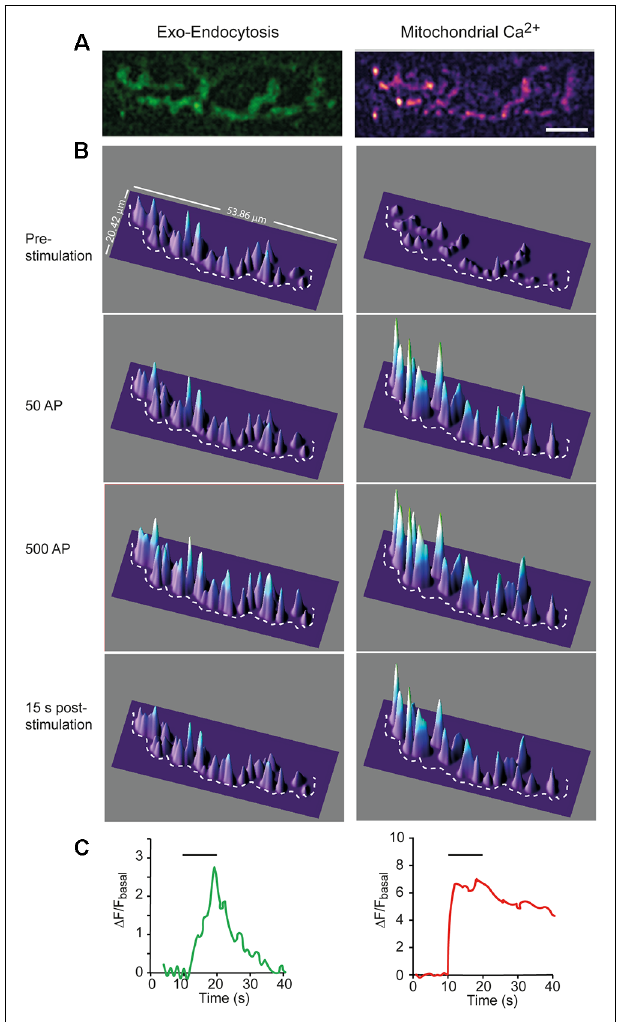
FIGURE 1 | Simultaneous recording of hot spots of exocytosis and mCa 2+ in a single nerve terminal. (A) Representative example of SypHy (left) and Rhod-2 (right) fluorescence signals recorded from a nerve terminal at the end of a 10 s stimulation train at 50 Hz. Calibration bar: 10 µ m. (B) 3D intensity plots of the same terminal before, during stimulation (after 50 and 500 AP), and after stimulation. The dotted line partially displays the boundary of the terminal. (C) Mean intensity changes of SypHy (left graph) and Rhod-2 (right graph) vs. time at the terminal in (A) . Horizontal lines show the start and end of the stimulation